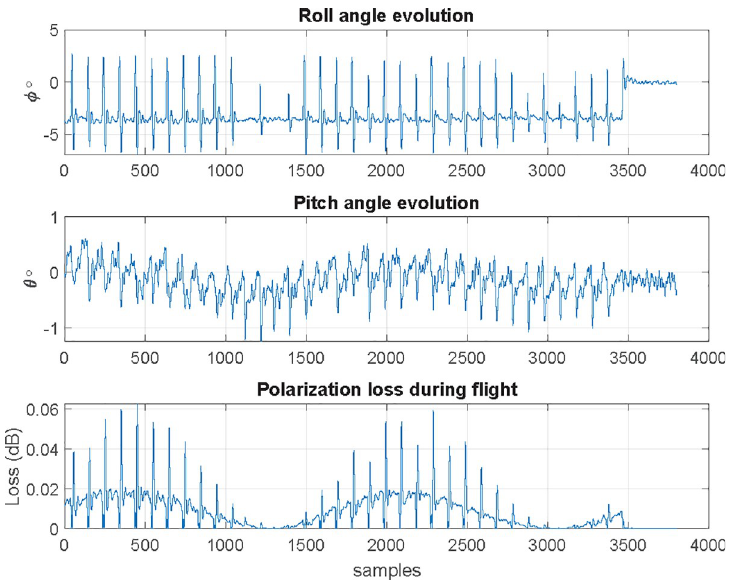
Fig 21. Polarization decoupling losses vs time for a polygonal flight under 10˚ resolution, 1 m/s ground speed and R = 50 m.